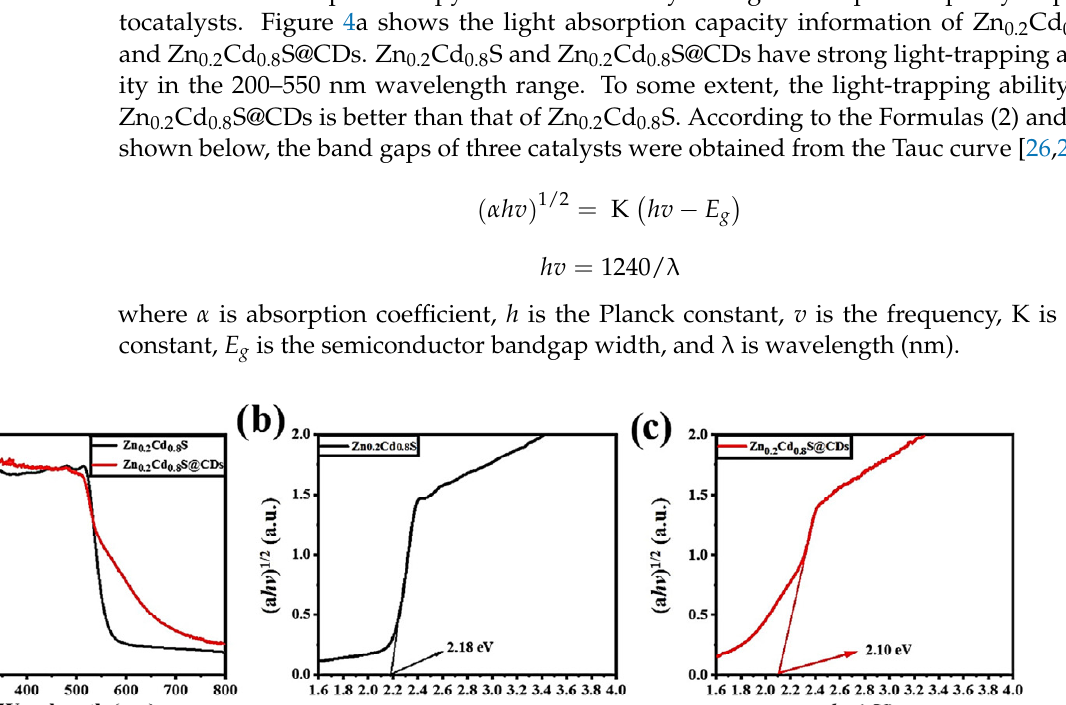
Figure 3. ( a ) Full scan XPS spectrum of the Zn 0.2 Cd 0.8 S@CD composite; high-resolution XPS O 1s; ( b ) N 1s; ( c ) C 1s; ( d ) spectrum of Zn 0.2 Cd 0.8 S@CDs.